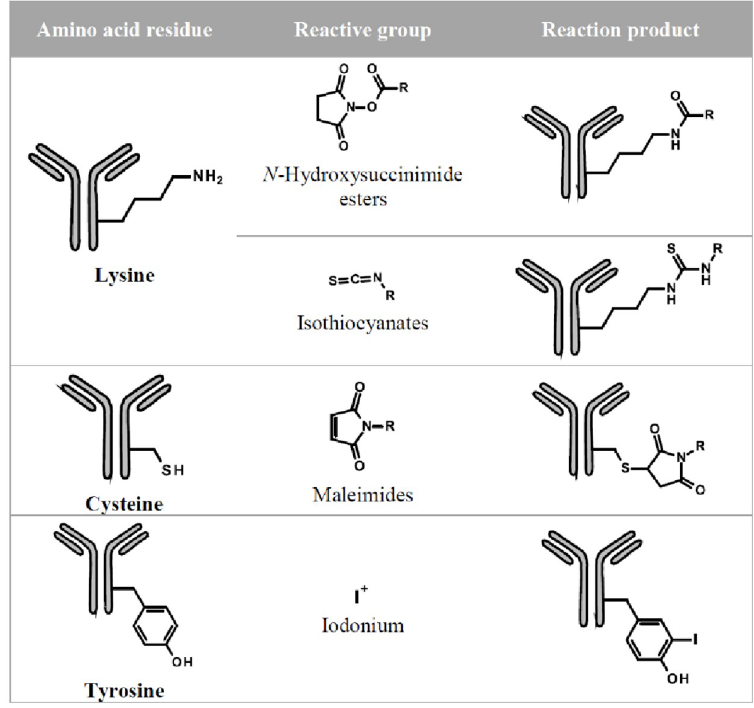
Fig 1. Overview of labelling techniques used in this study. Amino acid residues schematically represent the majority of the amino acids on which labelling or modification takes place. Reactive group describes the part of the label that conjugates with the corresponding amino acid side chain. The reaction product shows the formed chemical structural formula after the covalent linkage of the label to the protein.